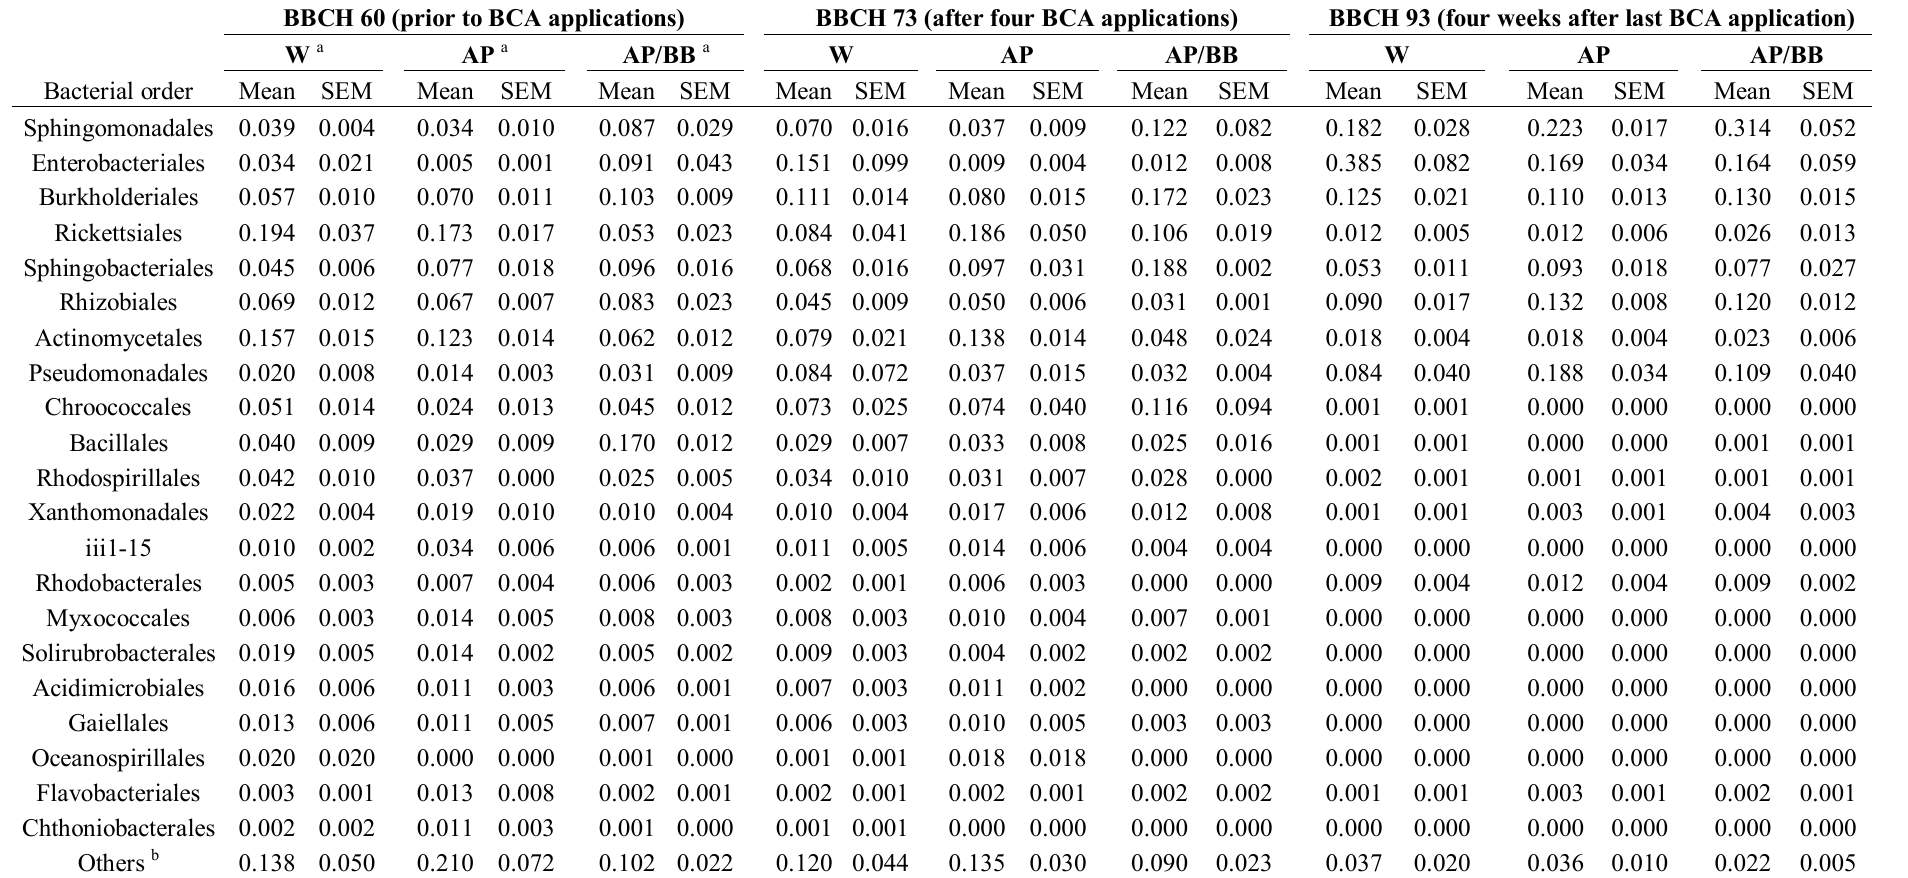
Table 5. Relative abundance of 16S rRNA reads assigned to bacterial orders in the strawberry phyllosphere at three distinct phenological stages (BBCH 60, BBCH 73, and BBCH 93) in 2012 as influenced by treatments with Aureobasidium pullulans as a single strain treatment (AP) or co-inoculated with Beauveria bassiana (AP/BB) through commercial formulations. The control (W) was treated with water from a lotic